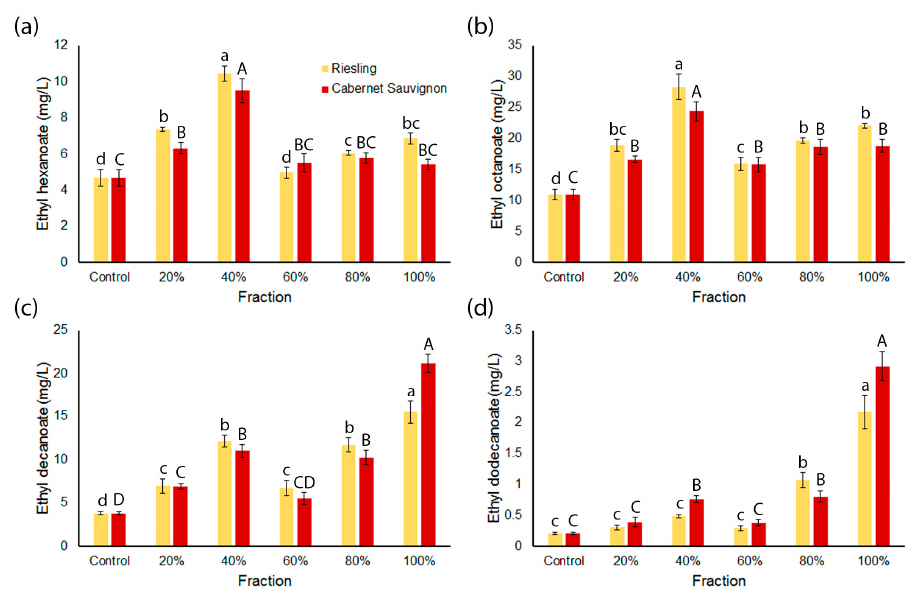
Figure 2. Concentrations of medium chain ethyl esters (MCEE) in wines fermented after addition of grape fractions. ( a ) Ethyl hexanoate; ( b ) ethyl octanoate; ( c ) ethyl decanoate and ( d ) ethyl dodecanoate. Values represent the mean concentration of analyte relative to the internal standard ( n = 3); error bars represent the standard error; and different letters denote significant differences between treatments at p < 0.05 using ANOVA followed by Duncan’s new multiple range test. Lower case = Riesling series. Upper case = Cabernet Sauvignon series.